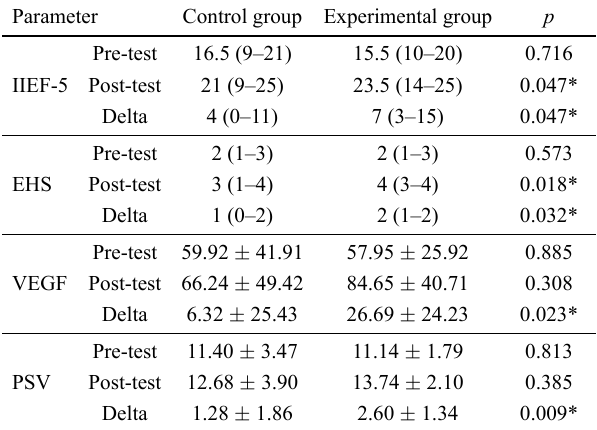
Table 6. Comparison of all parameters between